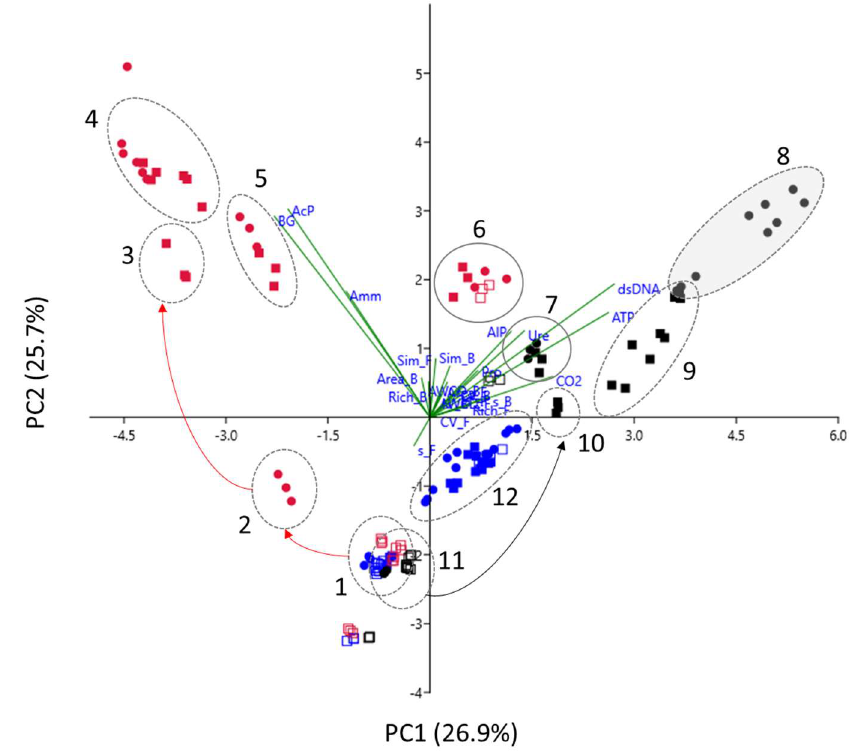
Figure 6. Principal component analysis (PCA) score plots based on the relative distribution of the original soils Val (red), Rom (blue) and Vic (black) together with sterilized and non-inoculated soils, Val*, Rom* and Vic*, as well as the sterilized and self- or cross-reinoculated soils after 1 day (empty squares), 7 days (circles) and 30 days (full square) of incubation. Different clusters have been numbered as follows: 1 (Val*, day1), 2 (Val*, day 7), 3 (Val*, day30), 4 (Val*+Val, Val*+Rom), 5 (Val*+Vic), 6 (Val), 7 (Vic), 8 (Vic*+Val, Vic*+Vic, Vic*+Rom, day 7), 9 (Vic*+Val, Vic*+Vic, Vic*+Rom, day 30), 10 (Vic*, day30), 11 (Vic*, day 1 and 7), 12 (Rom, Rom*, Rom*+Rom, Rom*+Val, Rom*+Vic). Percentages correspond to the variance explained in each axis (PC1 = 26.9%, PC2 = 25.7%).